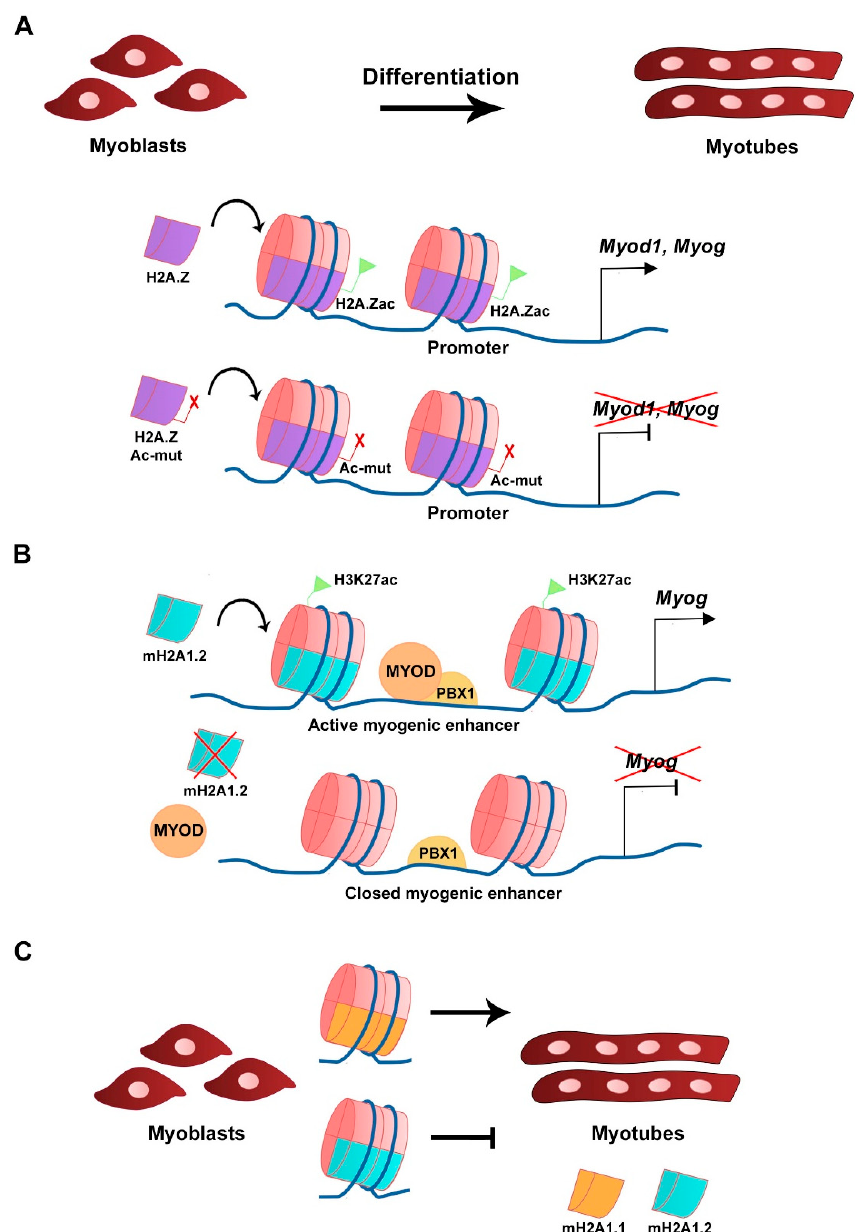
Figure 2. Histone H2A variants in myogenesis. ( A ) Acetylation of H2A.Z variant at the CER is required for Myod1 expression and myoblast differentiation. Overexpression of a mutated and non- acetylatable form of H2A.Z inhibits Myod1 expression (Law and Cheung, 2015). ( B ) The mH2A1.2 variant is required for myogenic enhancer activation prior to differentiation and correlates with H3K27ac histone mark. mH2A1.2 enrichment allows MYOD-PBX1 complex formation at the Myog promoter, activating transcription (Dell’Orso et al., 2016). ( C ) Distinct mH2A1 isoforms have different roles on myoblast differentiation (Hurtado-Bagès et al., 2020).